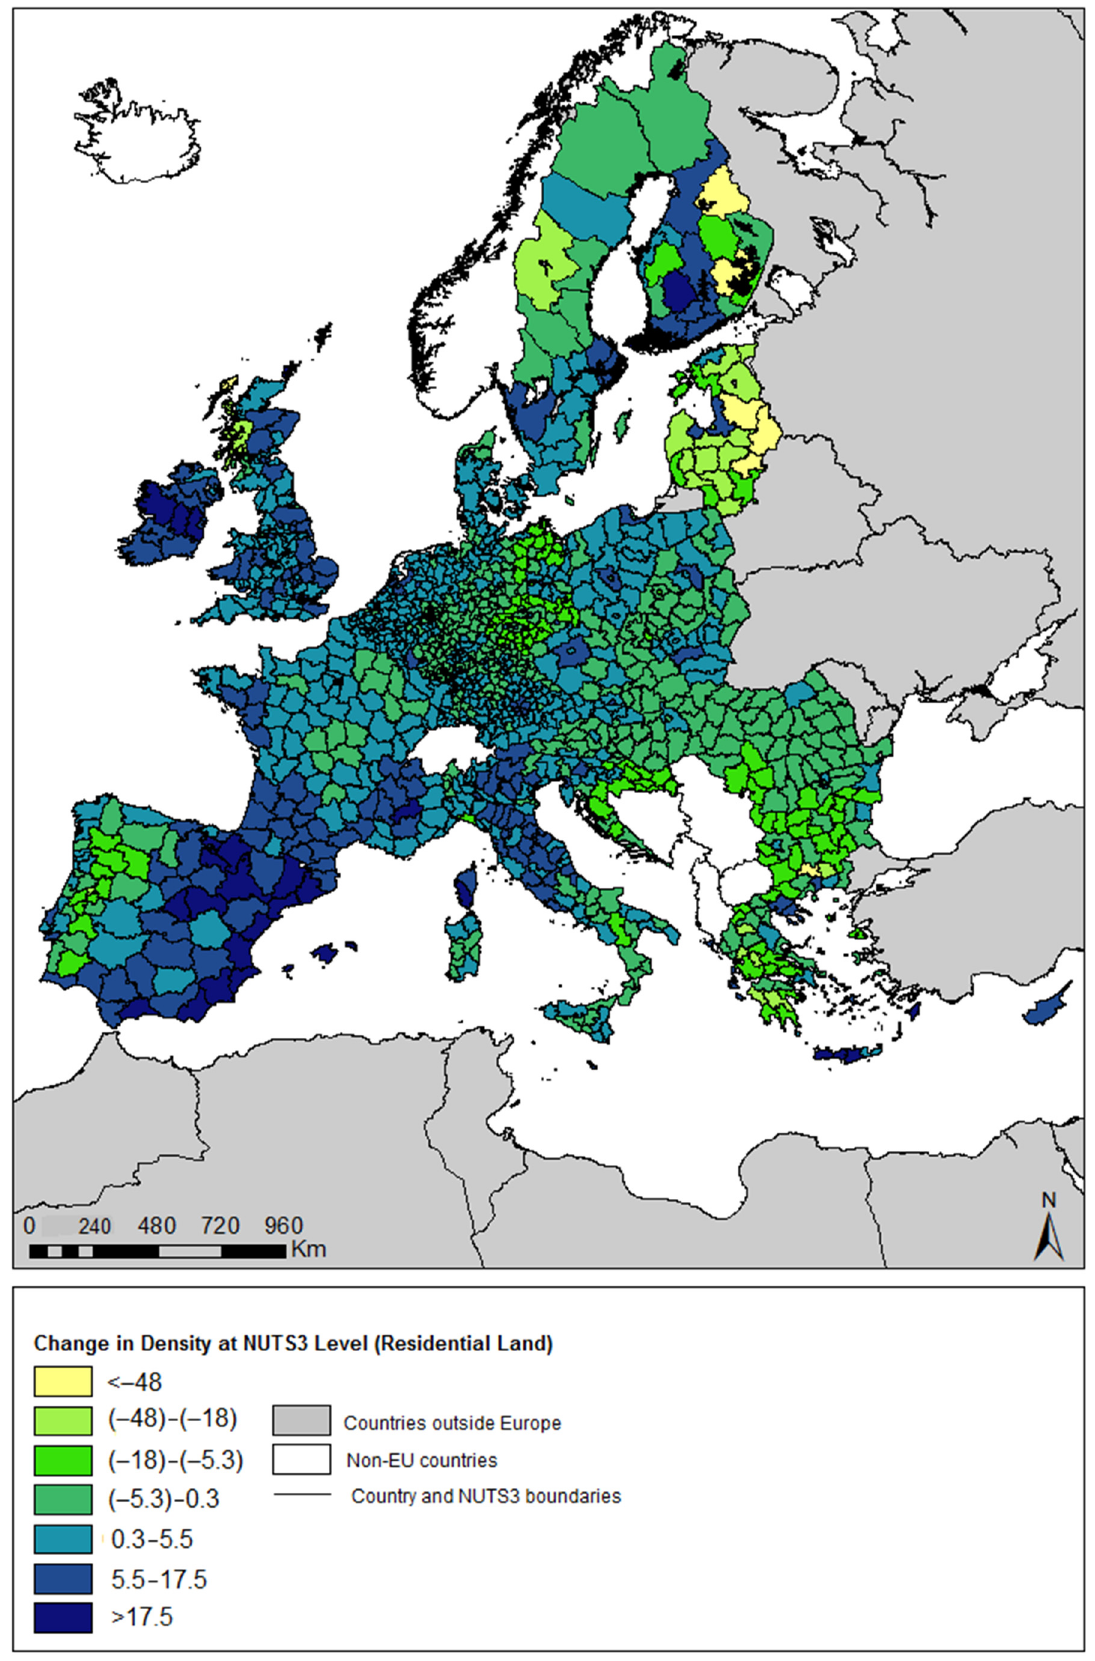
Figure A2. Change in density (NUTS3 level) between 2000 and